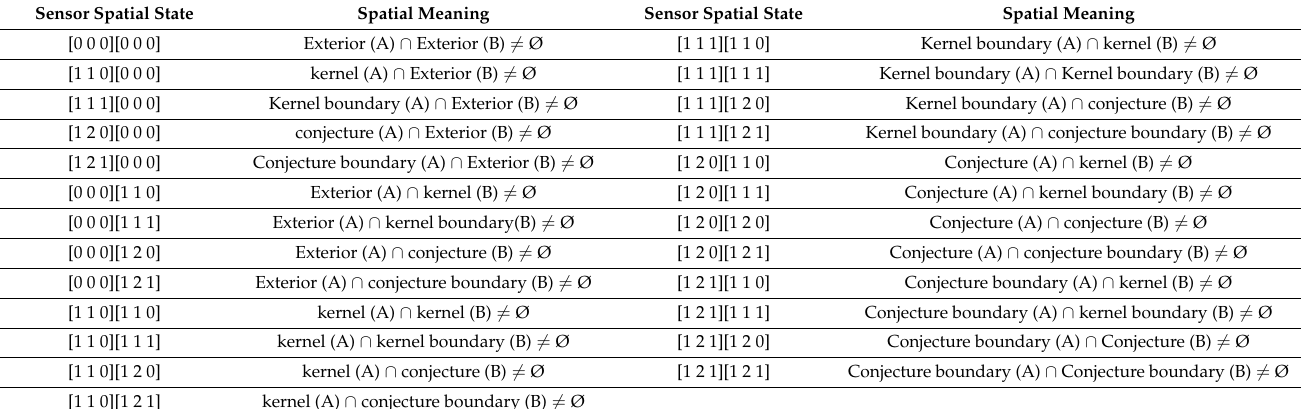
Table 1. Possible sensor spatial